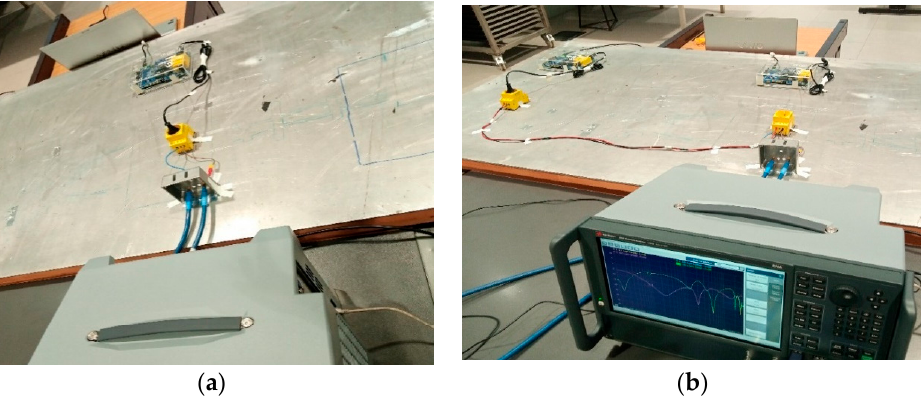
Figure 11. Experimental test bench to characterize ( a ) the PLC Tx modem and ( b ) the PLC Rx modem together with the transmission line.